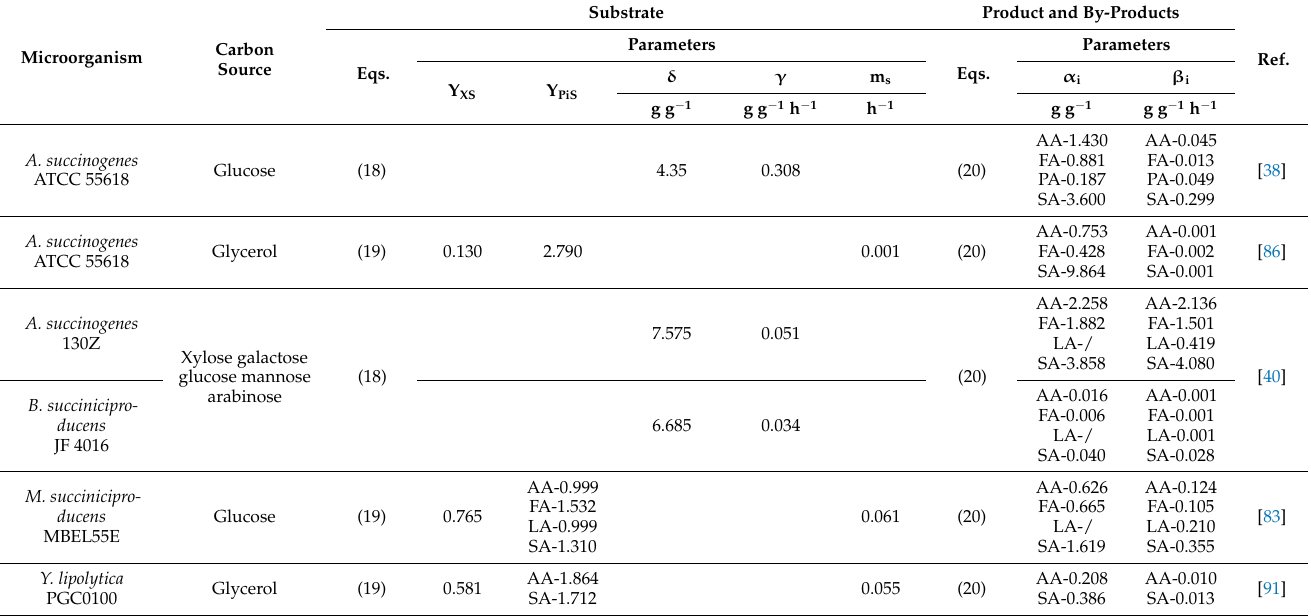
Table 3. Parameters from non-segregated unstructured kinetic models considering substrate con- sumption and product generation in SA